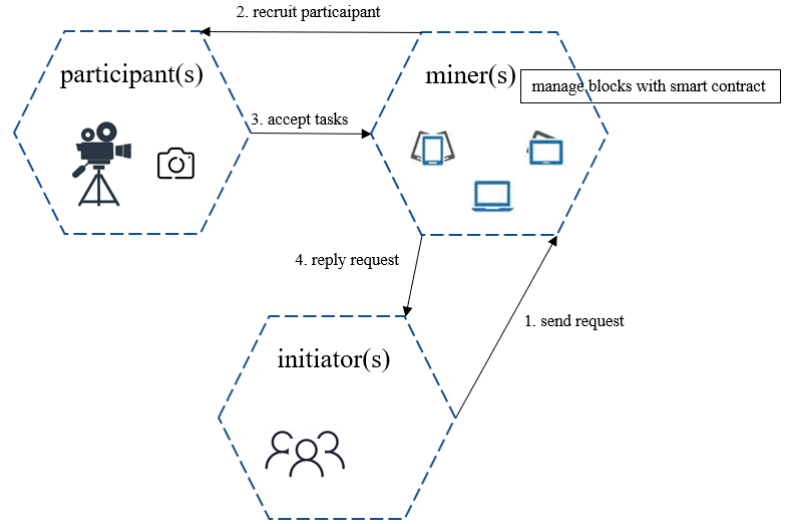
Figure 4. Roles of target tracking system.